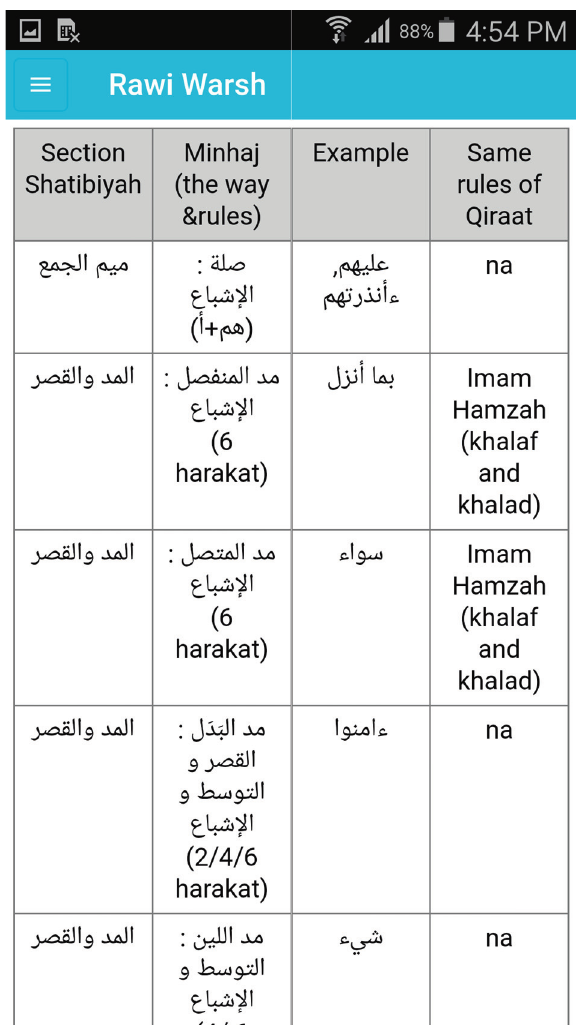
Figure 9: Sample references on the recitation rules for the chosen Imam and